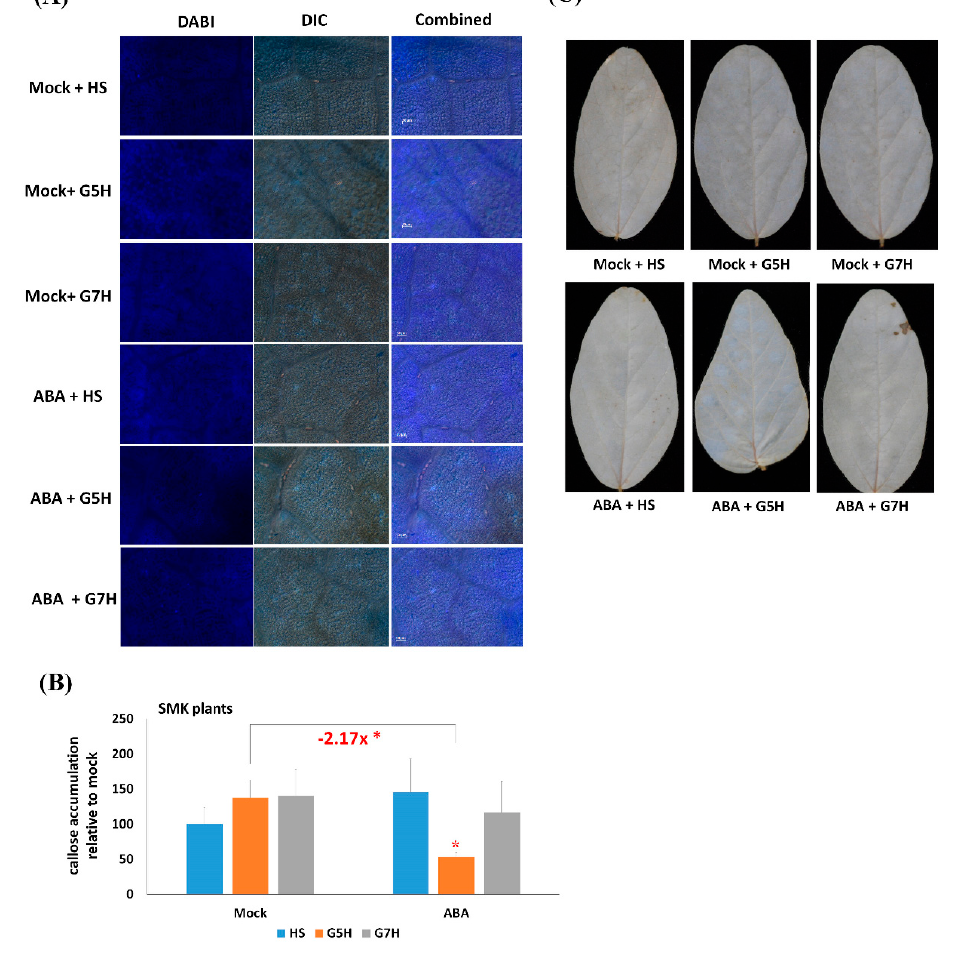
Figure 3. Levels of callose and ROS in SMK plants as affected by ABA treatment and G7H or G5H infection. SMK plants were treated with combinations of Mock (0.1% MeOH) or ABA (100 µM), and sap from healthy plants (HS), sap from G7H-GFP-infected plants (G7H), or sap from G5H-GFP-infected plants. Samples were collected 5 dpi and subjected to ( A ) aniline blue staining to detect callose accumulation levels, ( B ) quantification of callose fluorescence, and ( C ) DAB staining to reveal ROS accumulation. The experiment was carried out in three independent replicates, and values are means ± SD of three biological replicates. Statistical analysis was carried out as described in Figure legend 1, with additional comparison between Mock-G5H and ABA-G5H plants. Asterisks in red color indicate significant decrease at P <